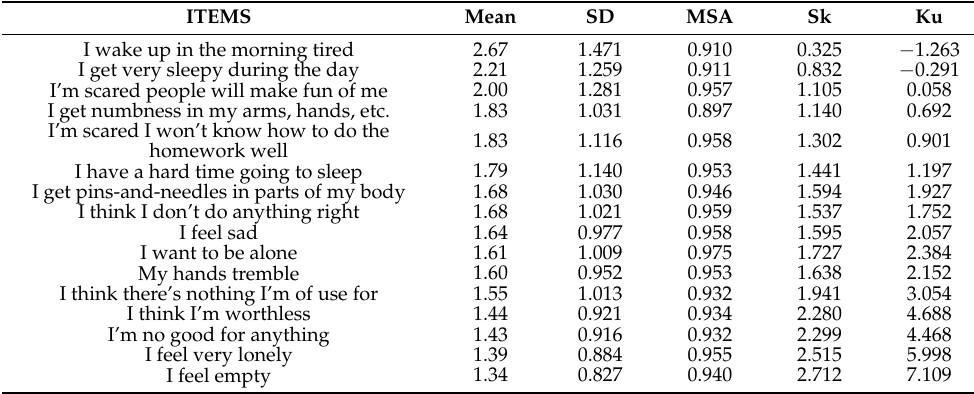
Table 3. Main descriptive statistics of the emotional problems detection